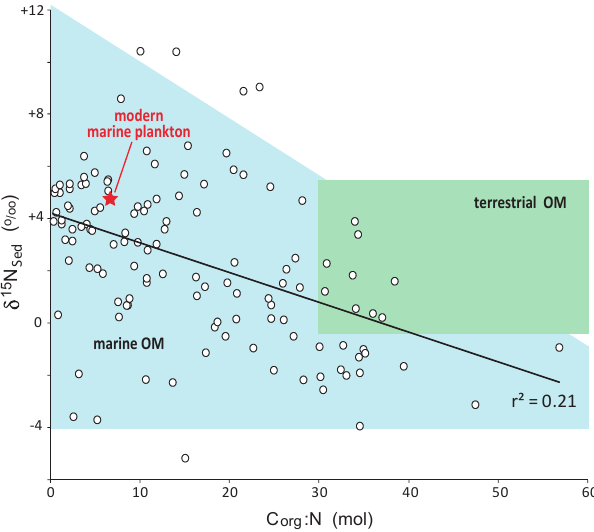
Figure 3 Fig. 3. δ 15 N sed versus δ 13 C org for 153 marine study units. The av- erage δ 15 N sed - δ 13 C org compositions for five depositional settings are shown by crosses (mean) and ovals (one standard error of the mean). The data set asa whole exhibits no significant covariation between δ 15 N sed and δ 13 C org . However, there are statistically sig- nificant differences in average δ 15 N sed - δ 13 C org compositions by depositional setting (see Sect. 4.4 and Fig. 5).